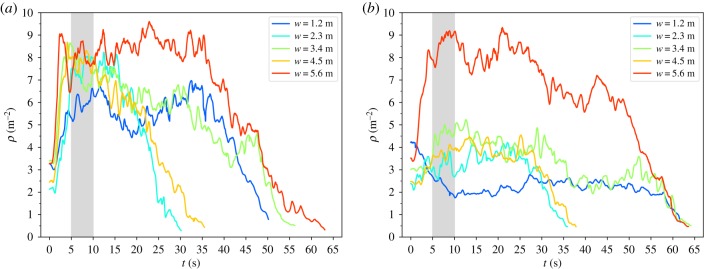
Time series of the mean density ρ within the measurement area (blue square in figure 1) for high motivation (a) and low motivation (b). The runs displayed are 110/120 (w = 1.2 m), 230/240 (w = 2.3 m), 270/280 (w = 3.4 m), 050/060 (w = 4.5 m) and 030/040 (w = 5.6 m).